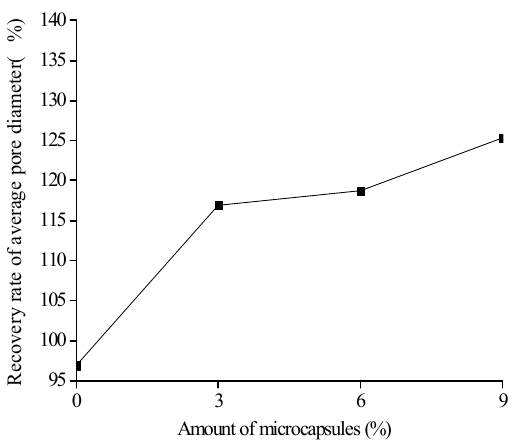
Figure 23. Recovery rate (Equation (9): η RAVE ) of average pore diameter with amount of microcapsules.